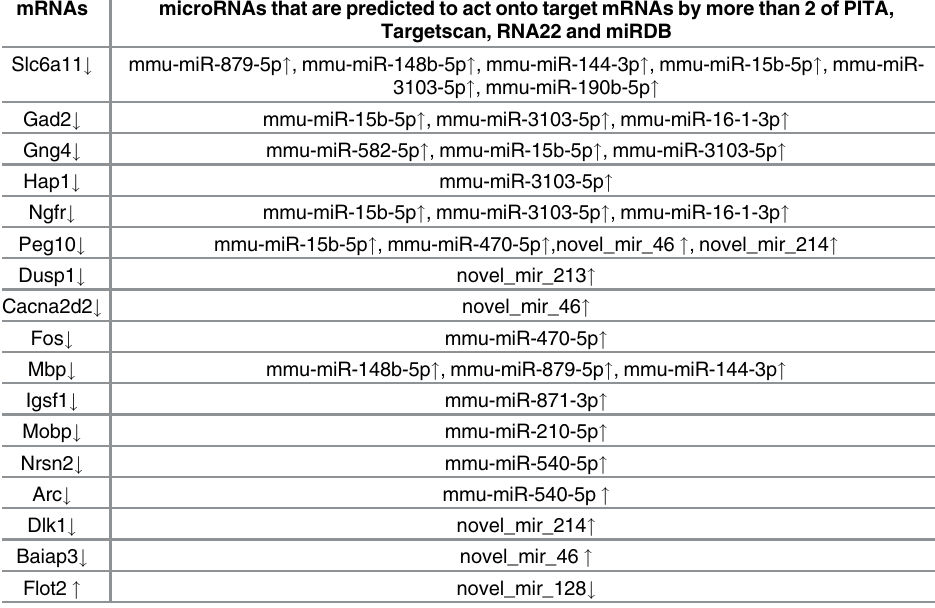
Baiap3 # Flot2 " novel_mir_128